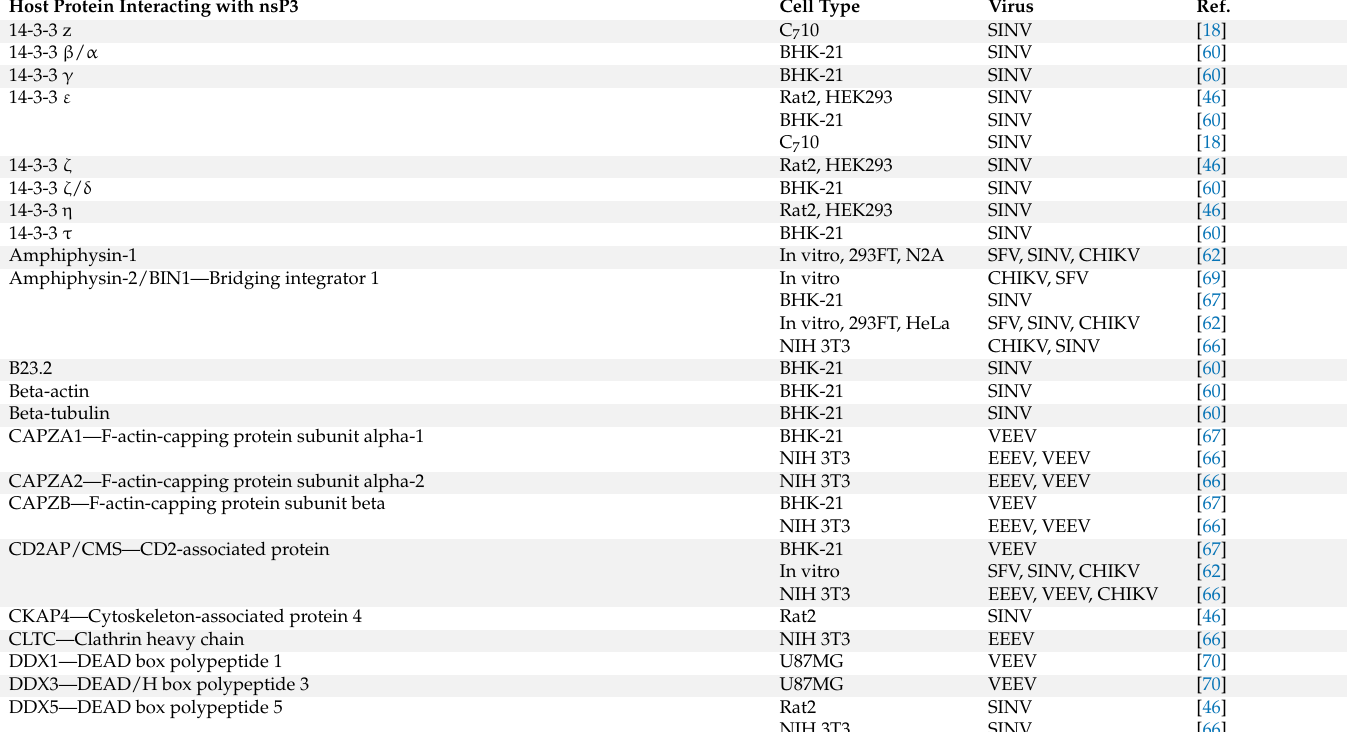
Table 1. Alphavirus nsP3-host interactions. The table summarizes cellular proteins reported to interact with alphavirus nsP3. Viruses and cell types involved in each study are indicated. For methodology please refer to the original publications. Cell types: BHK-21—Baby hamster kidney fibroblasts; C 7 10— Aedes albopictus